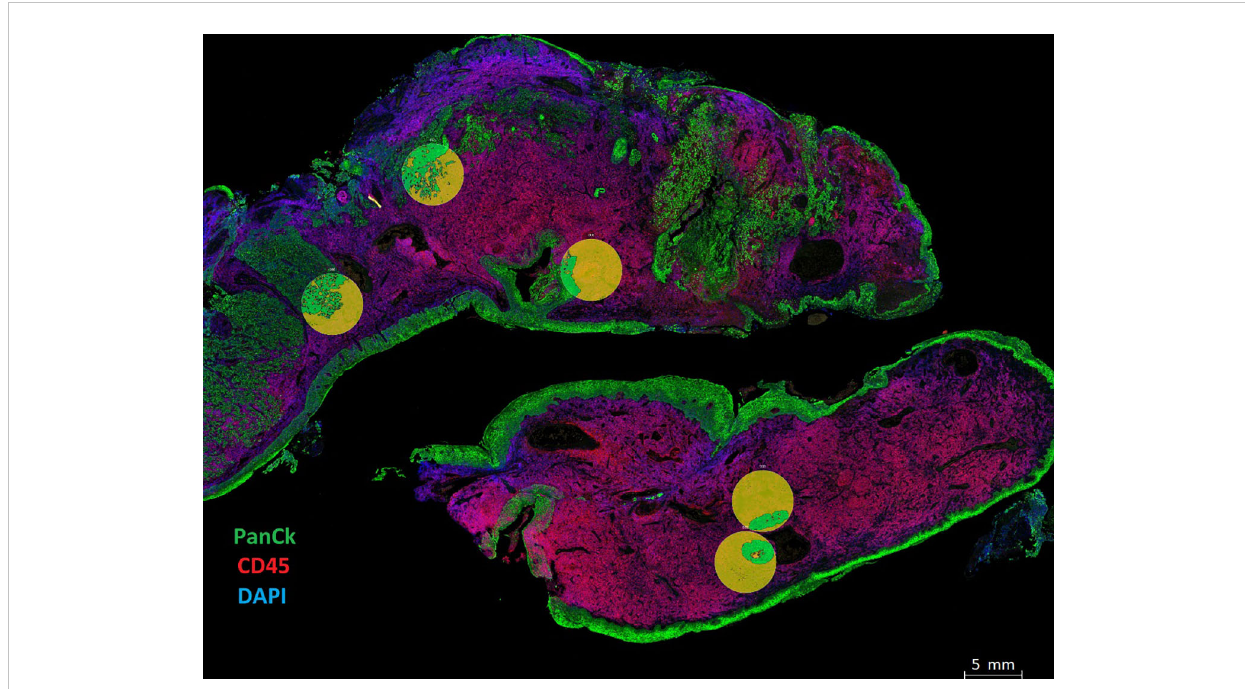
FIGURE 2 Spatial phenotyping on HNSCC tumor samples. Tissue compartmentalization was performed by masking panCK+ (Tumor) and panCK- (Stroma). The morphology markers included panCK (green) for tumor cells, CD45 (red) for immune cells, and SYTO 13 (blue) for the nucleus. Tumor segmentation on regions of interest (ROIs) was done to capture Tumor masks in green and Stromal regions in yellow. Masks were created using the panCK+/- feature to liberate barcodes for digital counting by the Nanostring nCounter